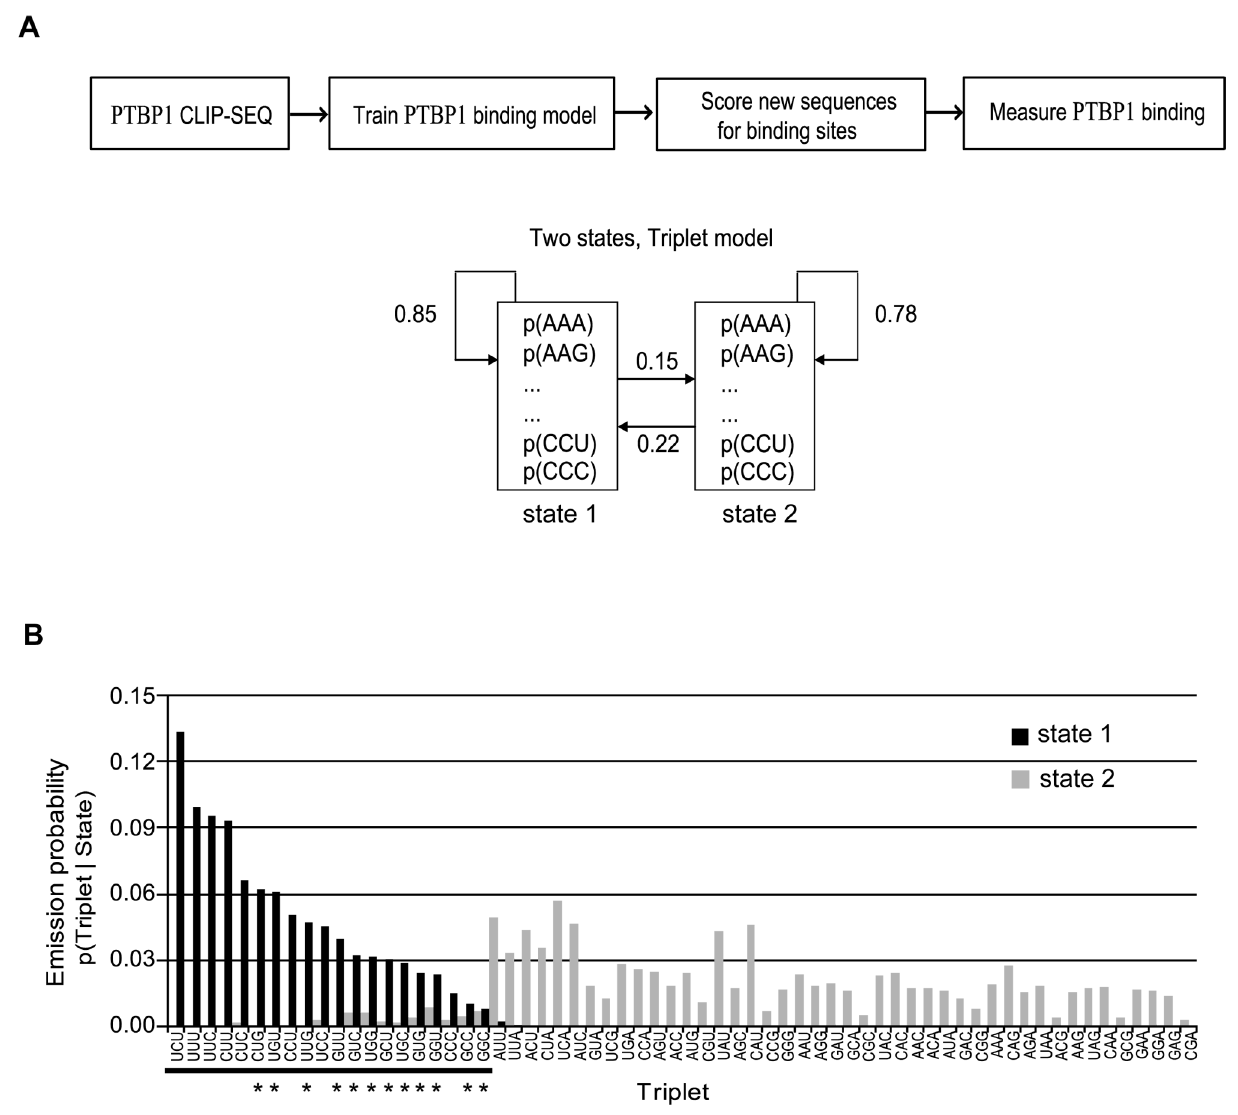
Figure 1. PTBP1 binding model. A . Scheme of the PTBP1 binding model. The two-state HMM model was trained on PTBP1 bound RNA sequences (48,604 clusters) from published PTBP1-CLIP experiments. Triplets from these CLIP clusters were predictive of two states, with all of the pyrimidine triplets preferred by State 1. The diagram presents the structure of the PTBP1 HMM (Hidden Markov Model) and its trained transition probabilities. B . The probabilities that triplets are seen states 1 or 2 (emission probabilities) are plotted in black and gray bars, respectively. Asterisks indicate G containing pyrimidine triplets.